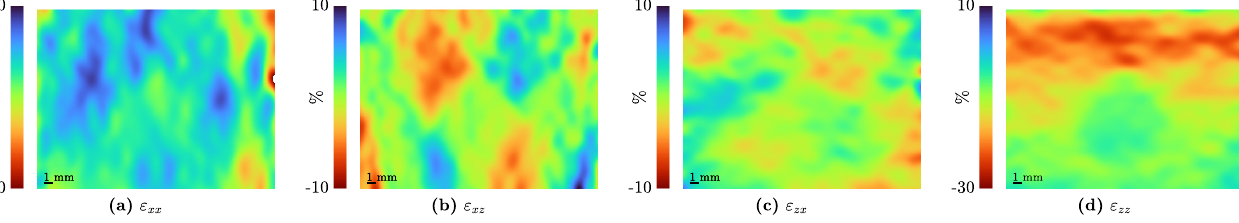
Figure 16. The four strain components in the specimen. The displayed region, compared to Figure 15, is cut, due to the non-valid entries of the convolution of the strain filter. Furthermore, the strain is warped to the actual position of the specimen element at that compression